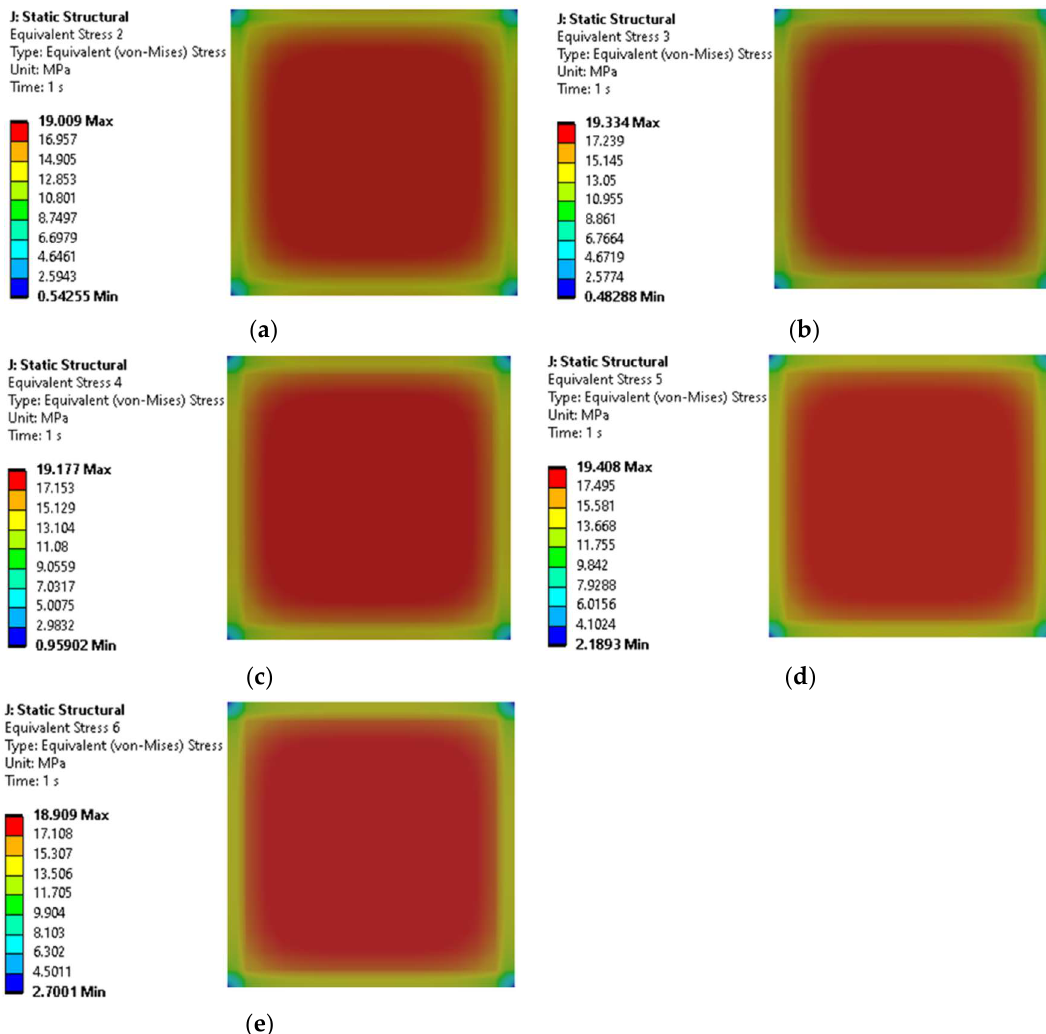
Figure 5. Residual stress profile in the TC: ( a ) 50 µm, ( b ) 100 µm, ( c ) 150 µm, ( d ) 200 µm y, and ( e ) 250 µm.